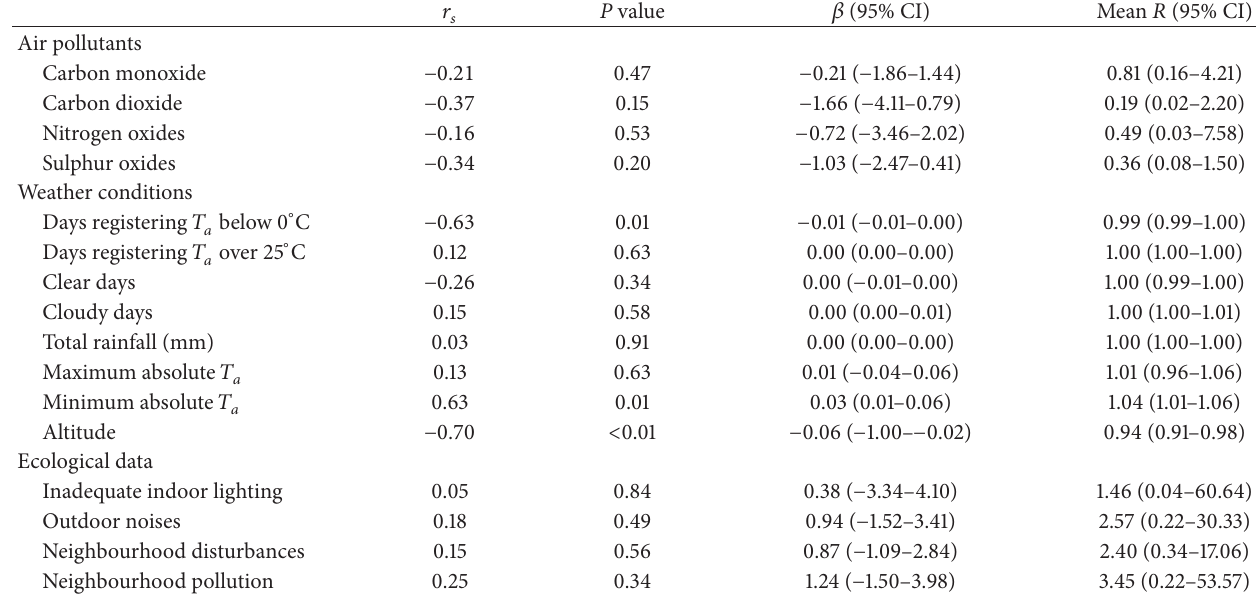
Table 3: Association analysis of the differences in migraine prevalence by a series of environmental and ecological factors defining regions.